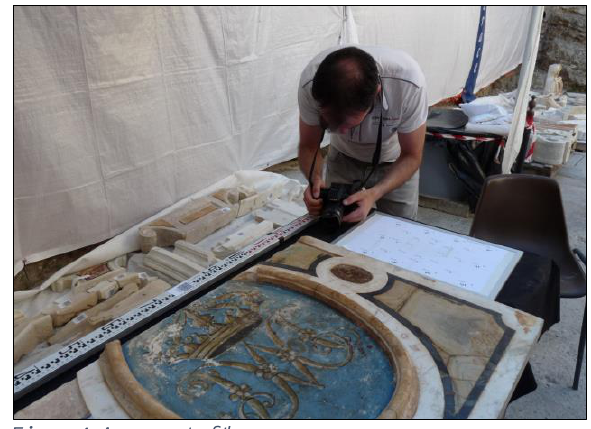
Figure 4. A moment of the